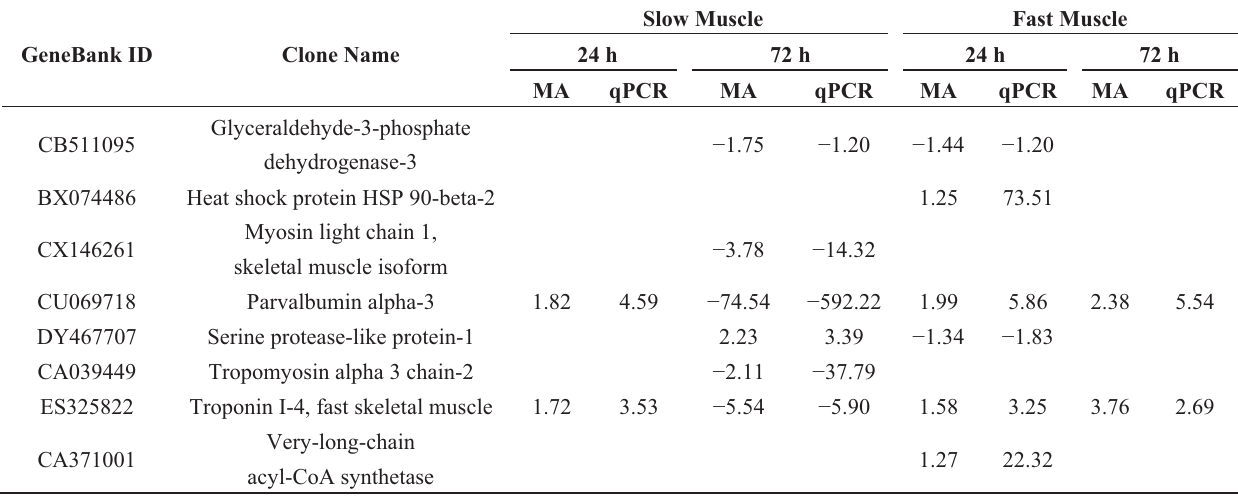
Table 1. Validation of microarray results by qPCR for selected genes in response to LPS a